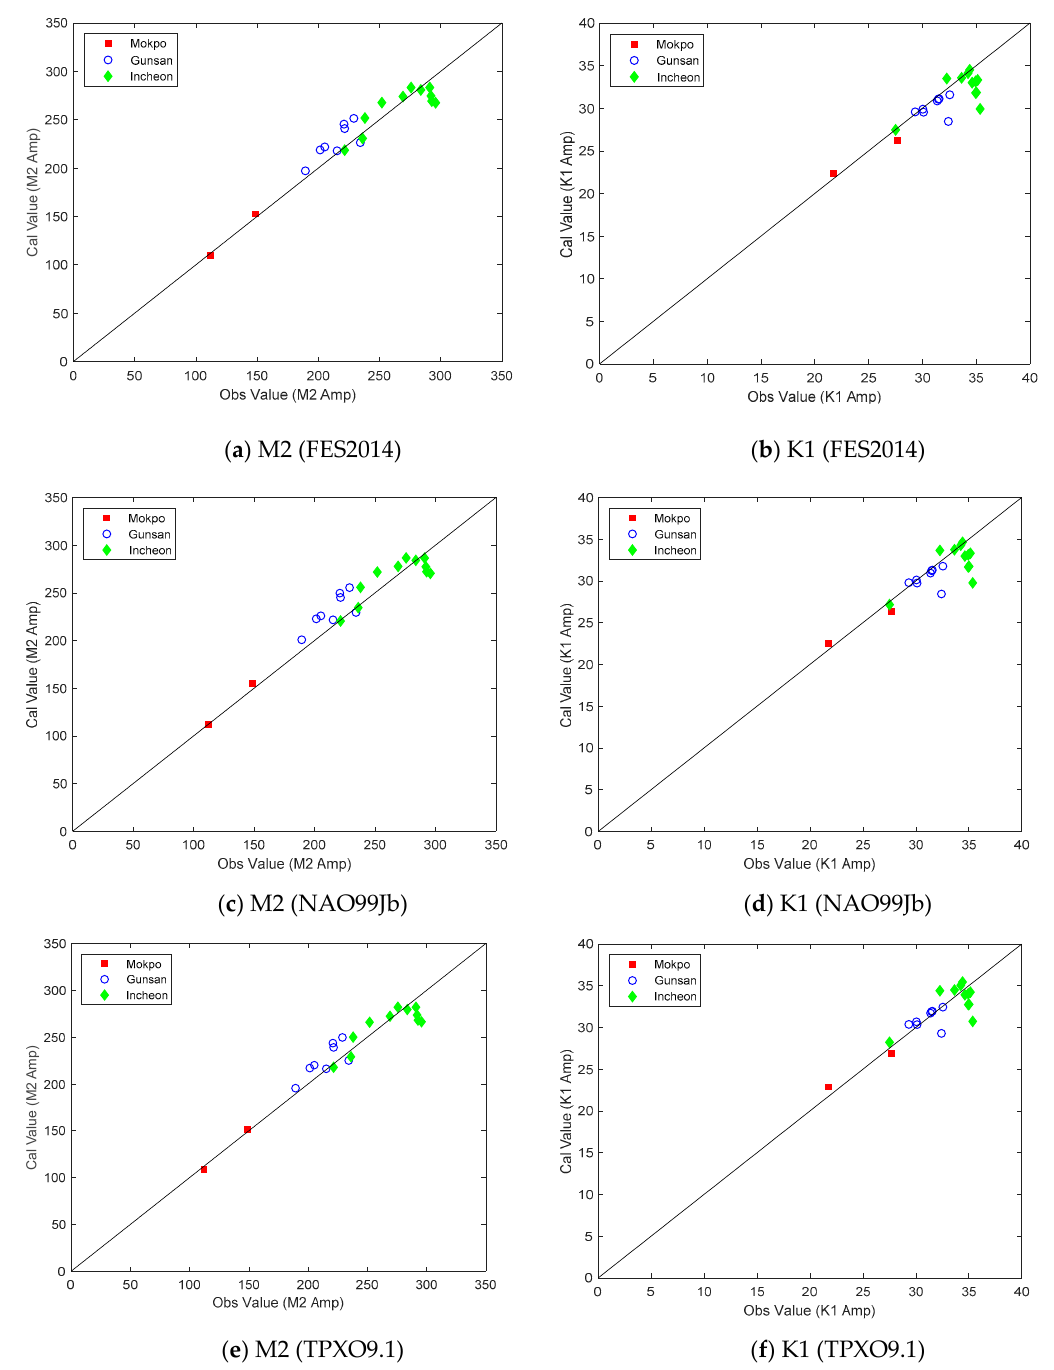
Figure 13. Comparison of the amplitudes between the observation and numerical simulation at tidal gauge stations (refer to Figure 6); ( a ), ( c ) and ( e ): M2’s amplitude; ( b ), ( d ) and ( f ): K1’s amplitude.